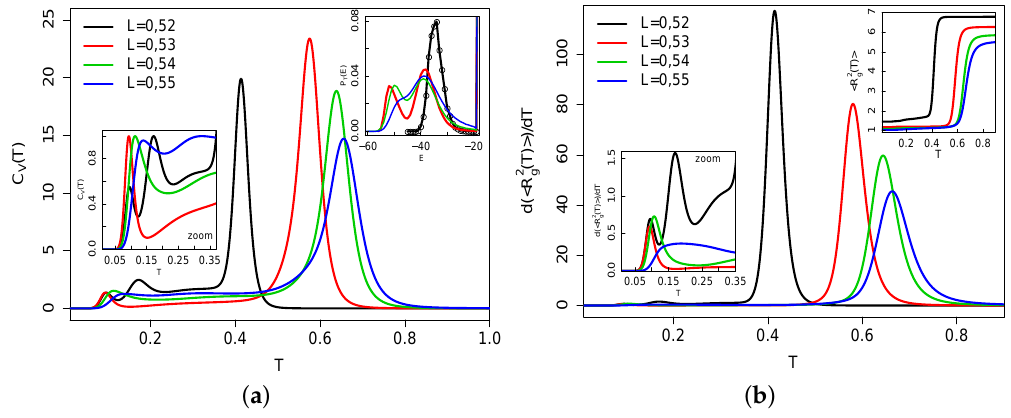
Figure 3. Part ( a ) shows the canonical specific heat for the stiff chains. The inset in the lower left corner shows the low temperature region in more detail. The inset in the upper right corner shows the probability distribution of the energy for the temperatures where the specific heat has a maximum. Part ( b ) shows the temperature derivative of the gyration radius for the same chains. The inset in the lower left corner highlights the low temperature behavior, the inset in the upper right corner shows the temperature dependence of the radius of gyration